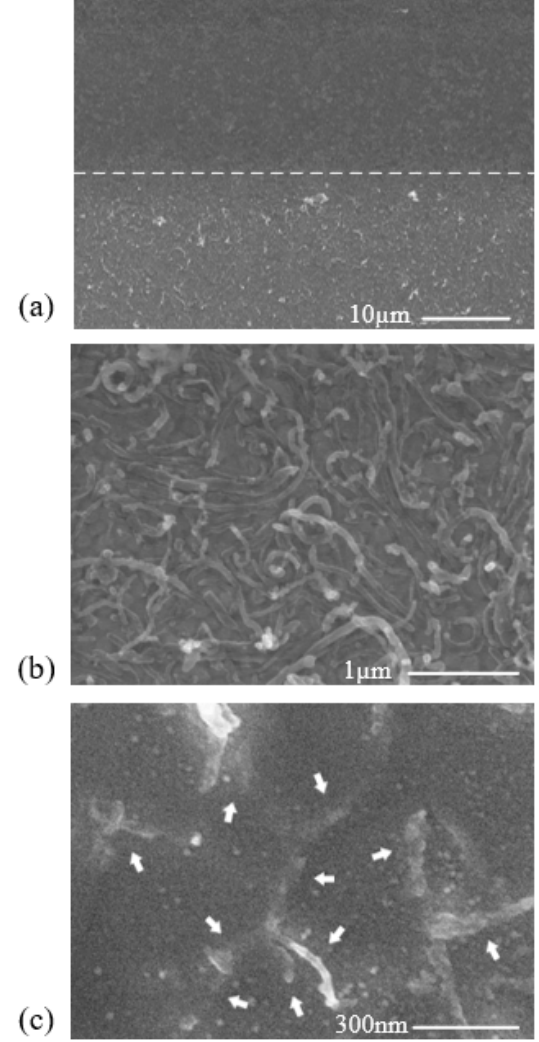
Figure 2. SEM images of the surface after welding a large number of MWCNTs onto Au at a laser energy density of 23.810mJ/cm 2 ; ( a ) Surface topography of the irradiation (upper side) and non-irradiation (lower side) areas; ( b ) A view in which the partial area is enlarged in the un-irradiation area. The arrows in ( c ) indicate that some of the short ends of the MWCNTs protrude from the solder substrate.